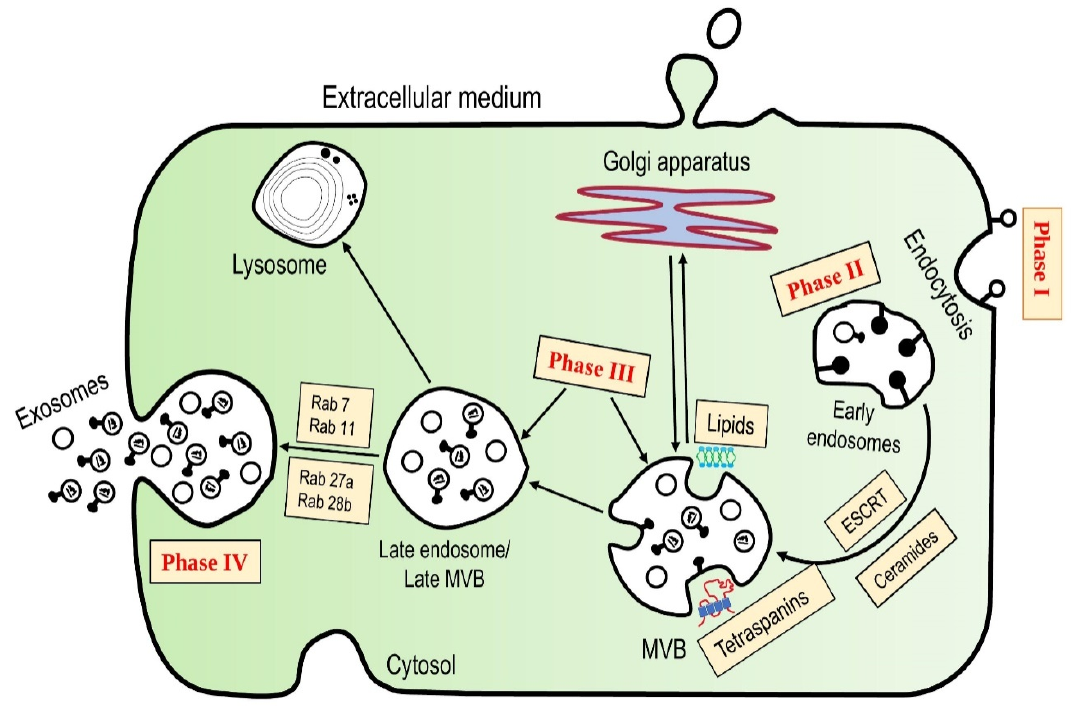
Figure 2. Exosome biogenesis; Phase I—Initiation, Phase II—Endocytosis, Phase III—Multivesicle formation, Phase IV—Secretion of exosomes.